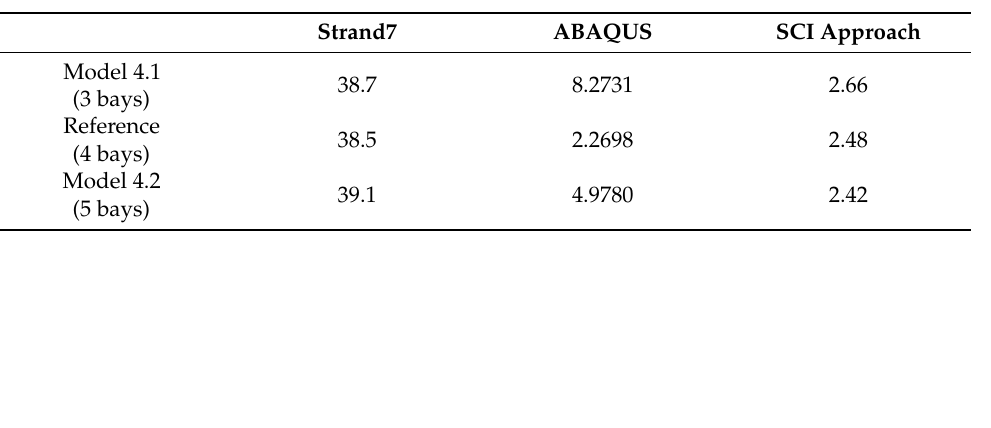
Table 13. Comparison of Response Factor between Different Number of